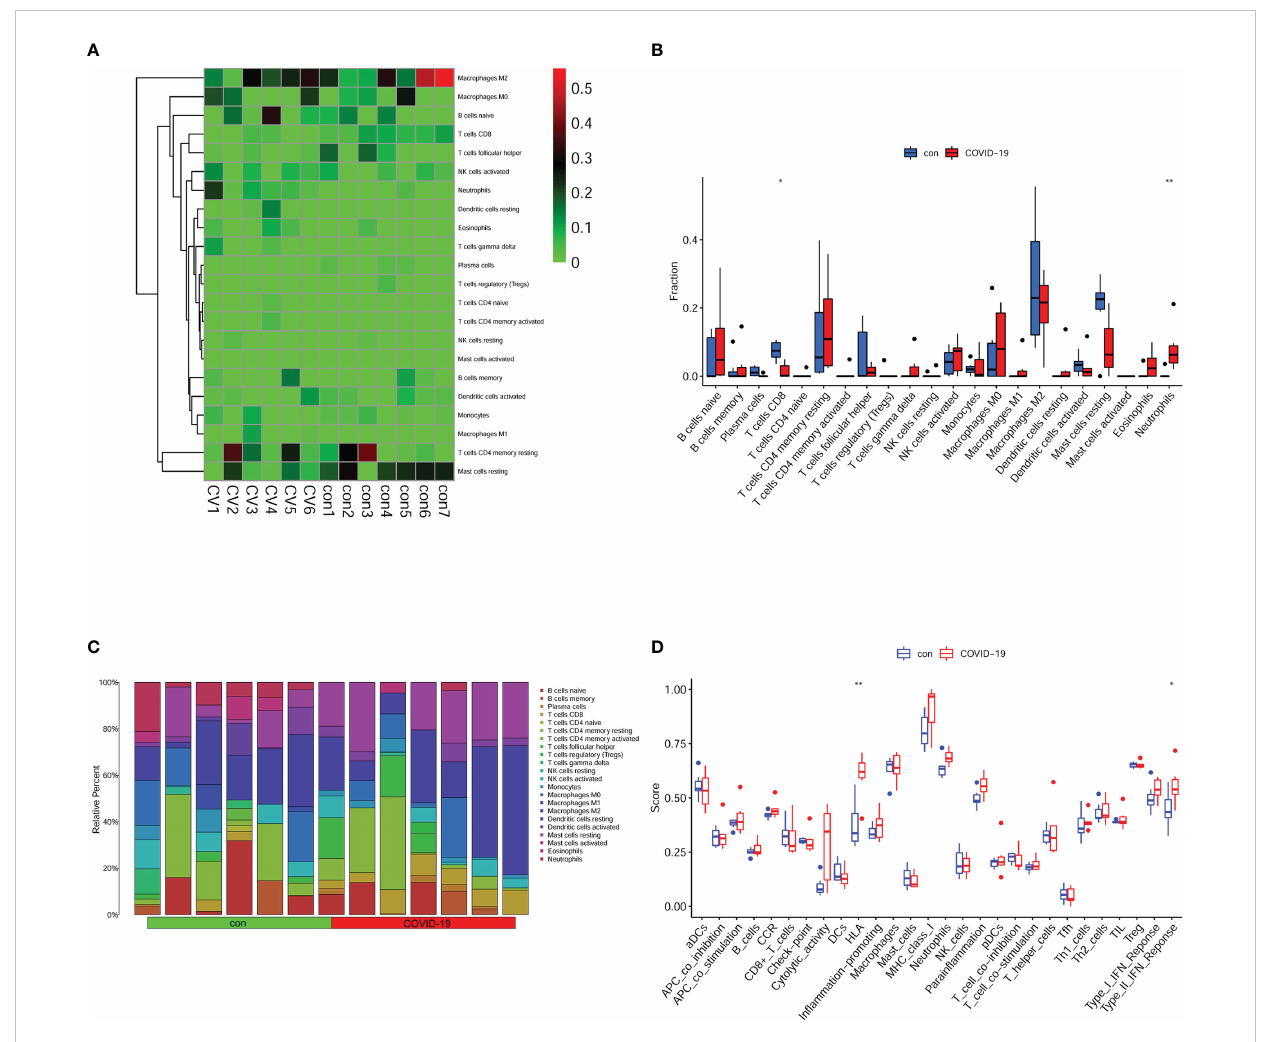
FIGURE 2 Immune landscape in the brain of Covid-19 patients. (A) immune cell distribution in each sample. (B) immune cell fraction in the brain of control and Covid-19 patients. (C) relative percent of immune cells in each sample. (D) immune function in the brain of control and Covid-19 patients. *p < 0.05; **p <